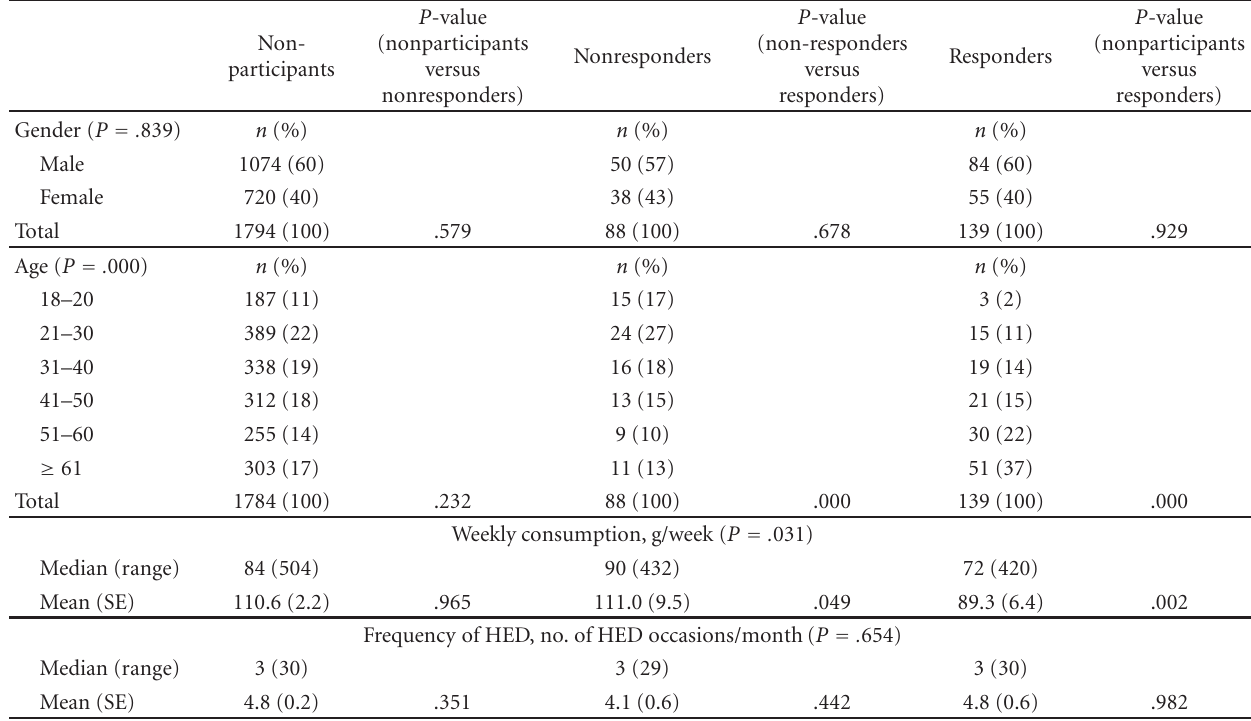
Table 2: Comparison of sociodemographic and drinking characteristic between nonparticipant, responders and nonresponders among those patients who did the test on their own